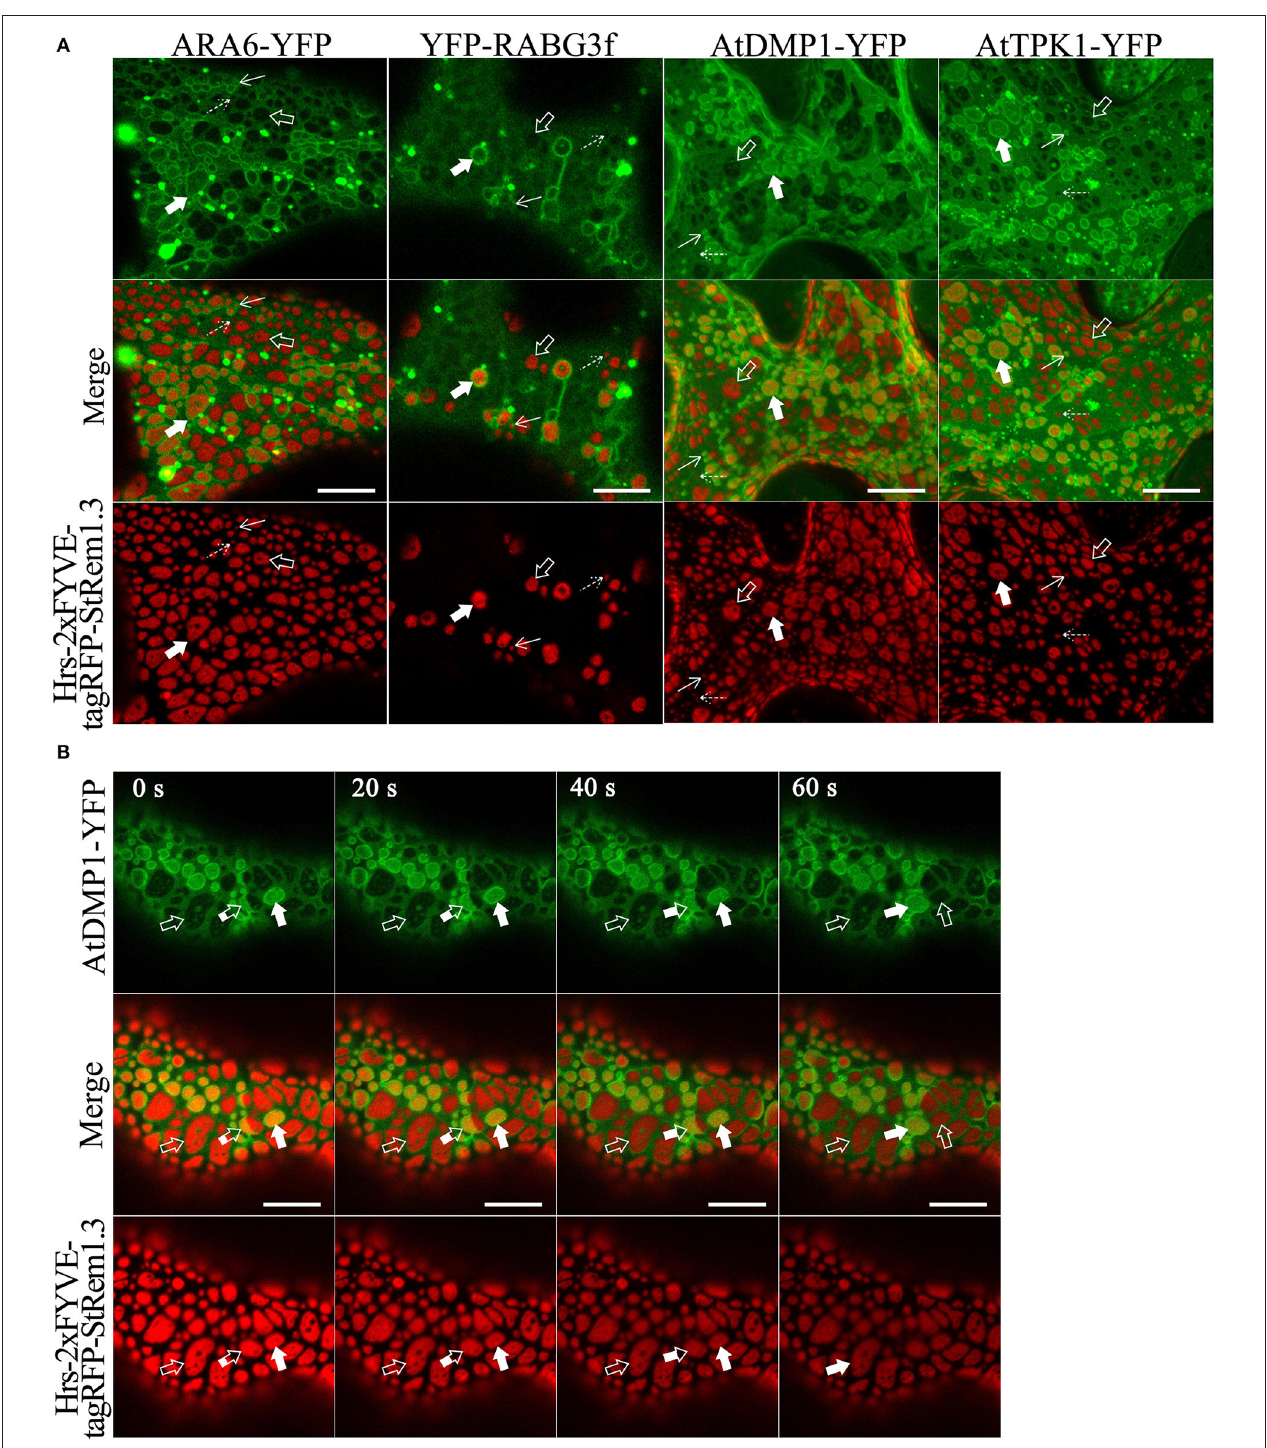
FIGURE 3 | Membrane patches can involve PM-tethering of either the tonoplast or MVBs. (A) Distinct tonoplast- and MVB-associated patches revealed by co-expression of YFP- or GFP-fused ARA6, RABG3f, AtDMP1, or AtTPK1 with Hrs-2xFYVE-tagRFP-StRem1.3. Examples of tonoplast- and MVB-associated patches are highlighted with open and filled arrows, respectively. Punctae associating with the tonoplast or MVBs, are highlighted by dotted and solid arrows, respectively. (B) Dynamic nature of interactions of patches with MVBs revealed by time-lapse imaging of AtDMP1-GFP co-expressed with Hrs-2xFYVE-tagRFP-StRem1.3. Examples of patches that are tonoplast-associated, MVB-associated, or dynamically associated are highlighted with open, fully filled and partially-filled arrows, respectively. Animation of this cell is shown in Supplementary Movie S1 . Scale bar in all panels represents 10 µ m.